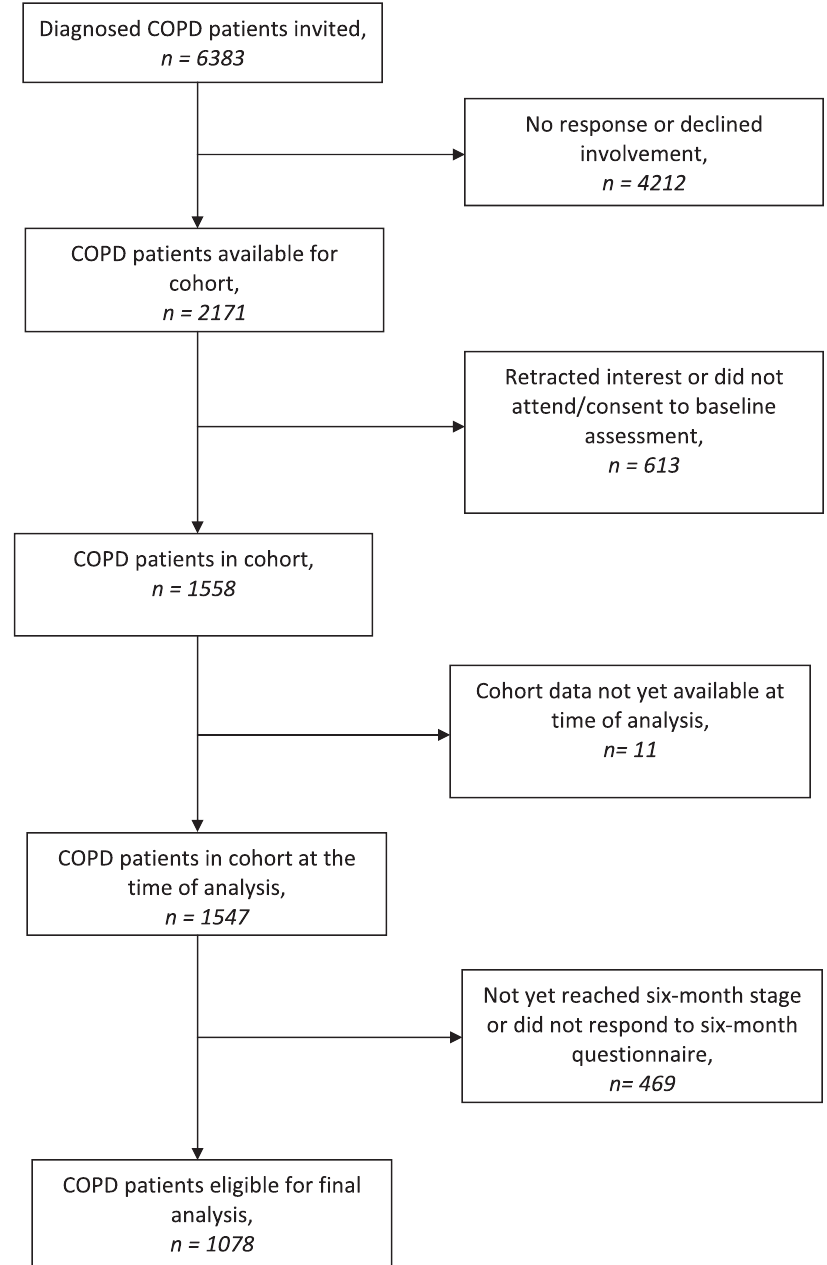
Fig. 1 Flow of participants from cohort to